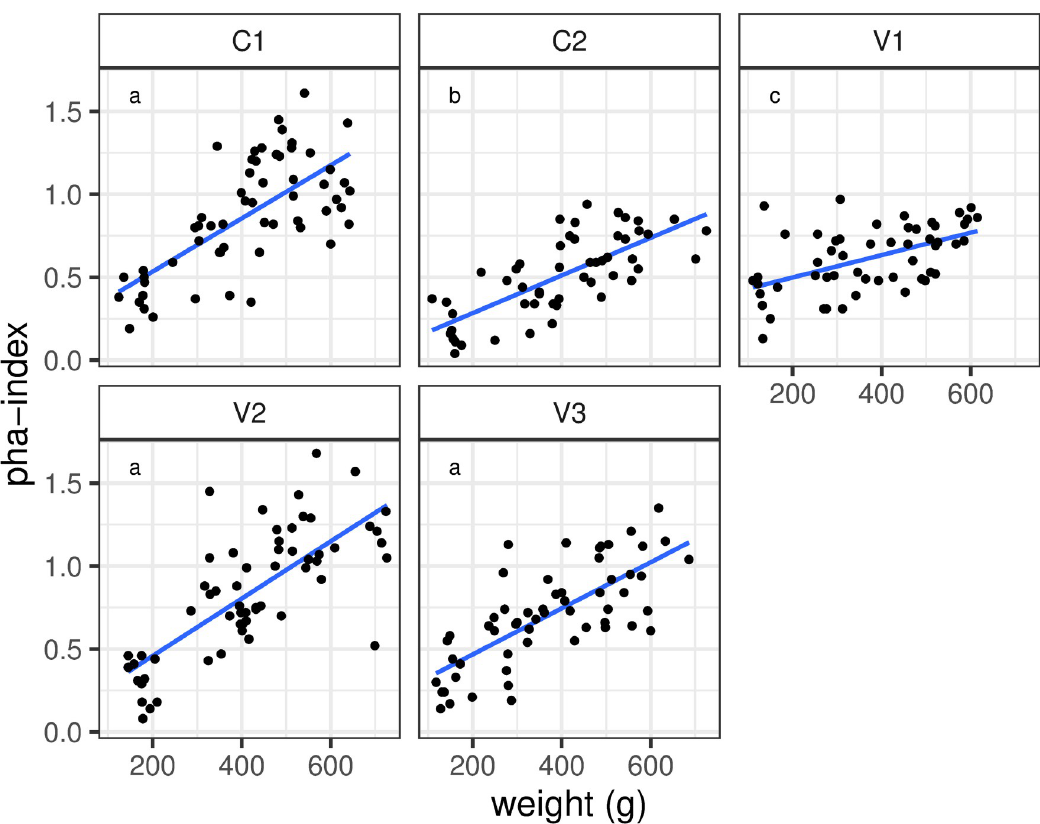
Fig 3. Trend lines presenting the results of the PHA test in correlation with body weight. Small letters indicate significantly different regression slopes between treatments.